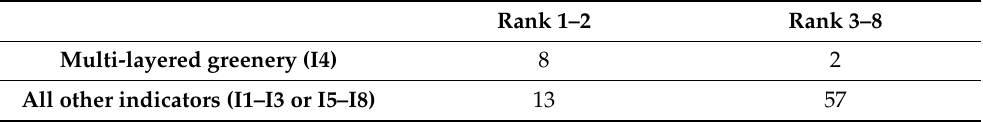
Table 2. Contingency table between indicators and rank of importance of the indicator for imageability of the urban